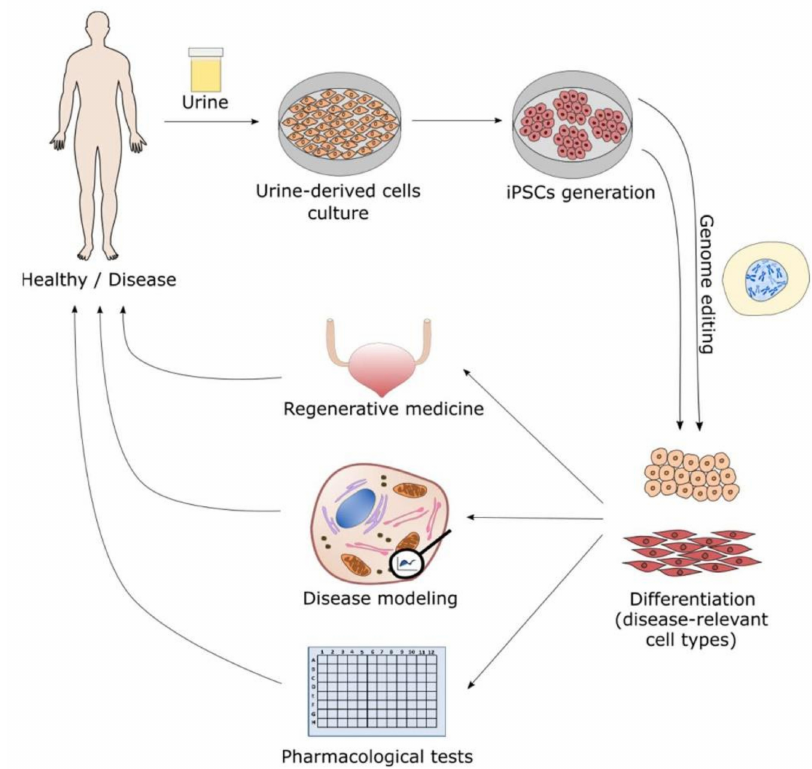
Figure 2. Possible applications for urine-derived cells. After urine collection from healthy or disease-a ff ected individuals, urine-derived cells are cultured and reprogrammed into induced pluripotent stem cells (iPSC). Those cells can be di ff erentiated into condition-relevant cell types maintaining the original genome. Otherwise, the genome can be edited to correct mutations or to introduce alterations associated with disease treatments or for research purposes. These di ff erentiated cells can be used for autologous or allogeneic regenerative medicine as a model to study diseases or for pharmacological tests, both in personalized or high-throughput